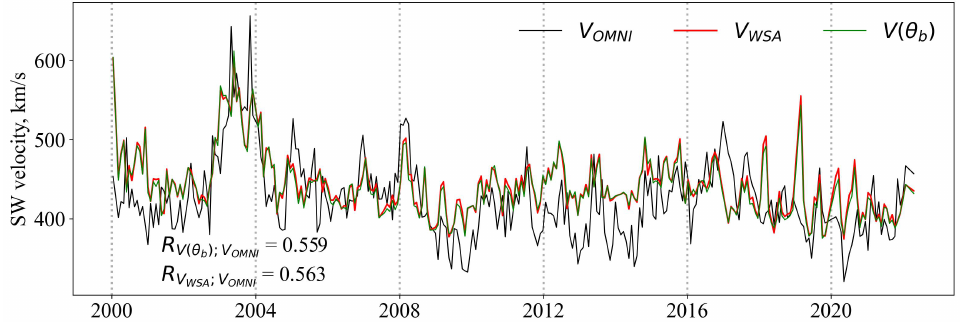
Figure 4. Example of a single-parameter dependence of the SW velocity V ( θ b ) ; comparison with the observed velocity V OMNI and with the velocity calculated according to the WSA model V WSA . Calculations using the CR-averaged